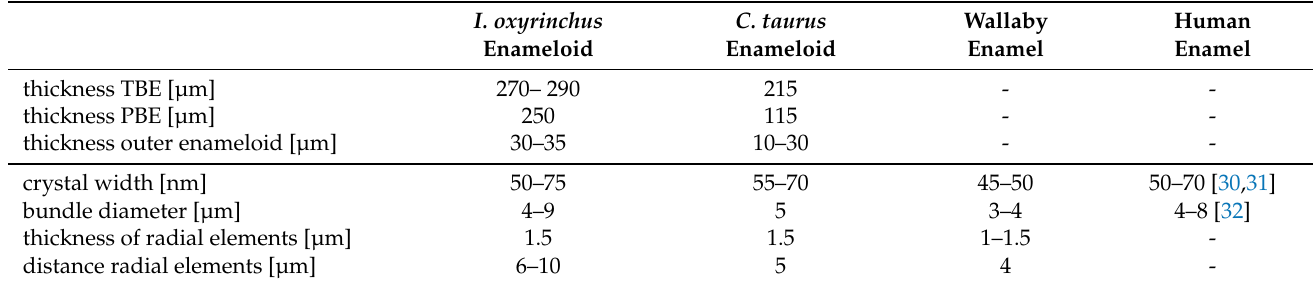
Table 1. Size of structural features in modern shark enameloid and mammalian